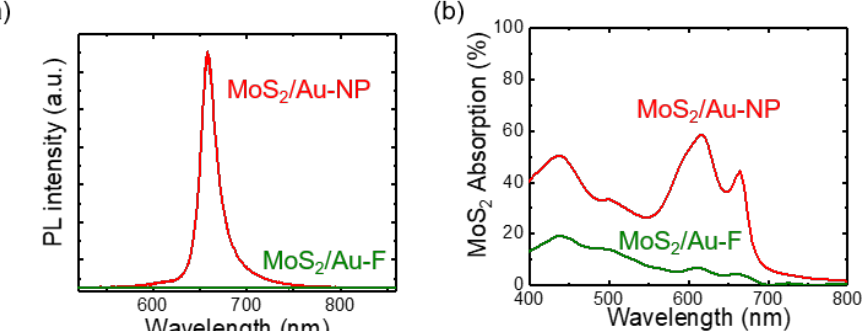
Figure 4. ( a ) Micro PL and ( b ) calculated absorption spectra of the MoS 2 monolayers on Au-F (green) and Au-NP (red), respectively.